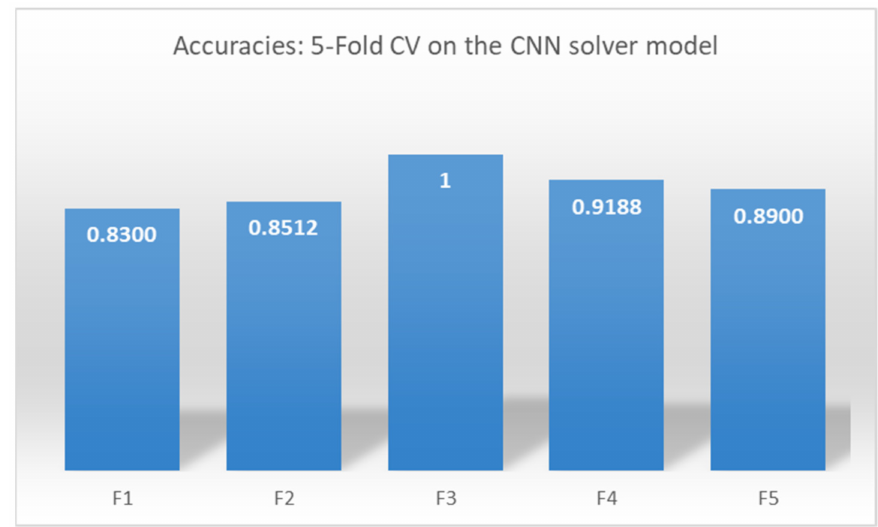
Figure 14. The accuracies achieved by the folds after performing five-fold cross-validation on the CNN solver model based on the original